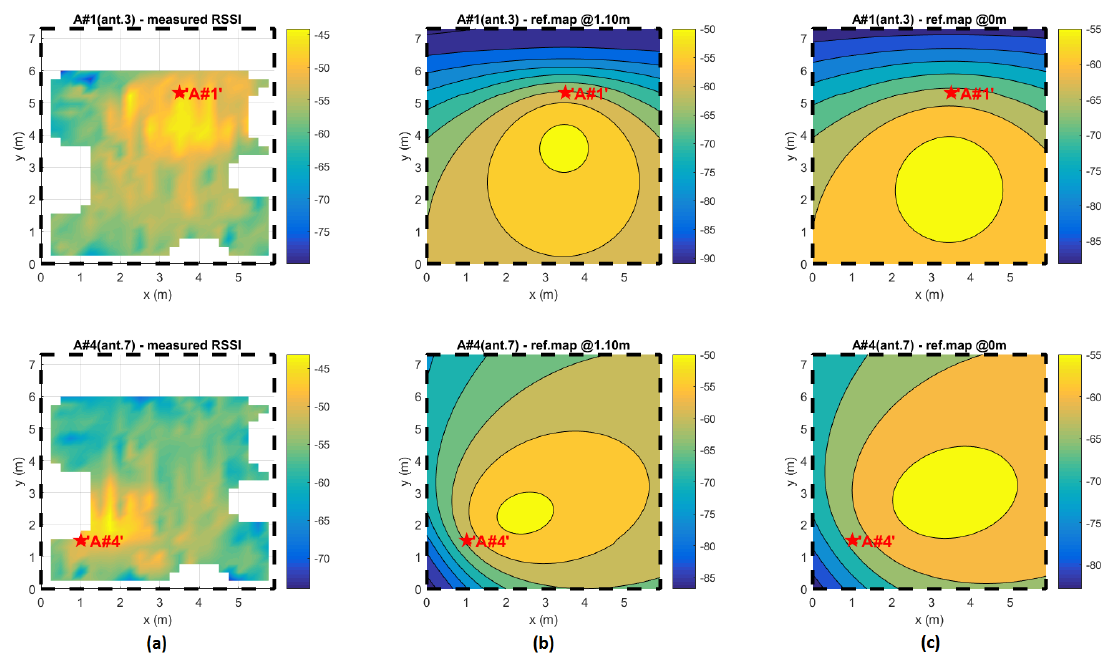
Figure 9. Collected RSSI values over the area ( a ) compared to the estimated RSSI values calculated ( b ) at z REF = 1.10 m and ( c ) at z REF = 0 m